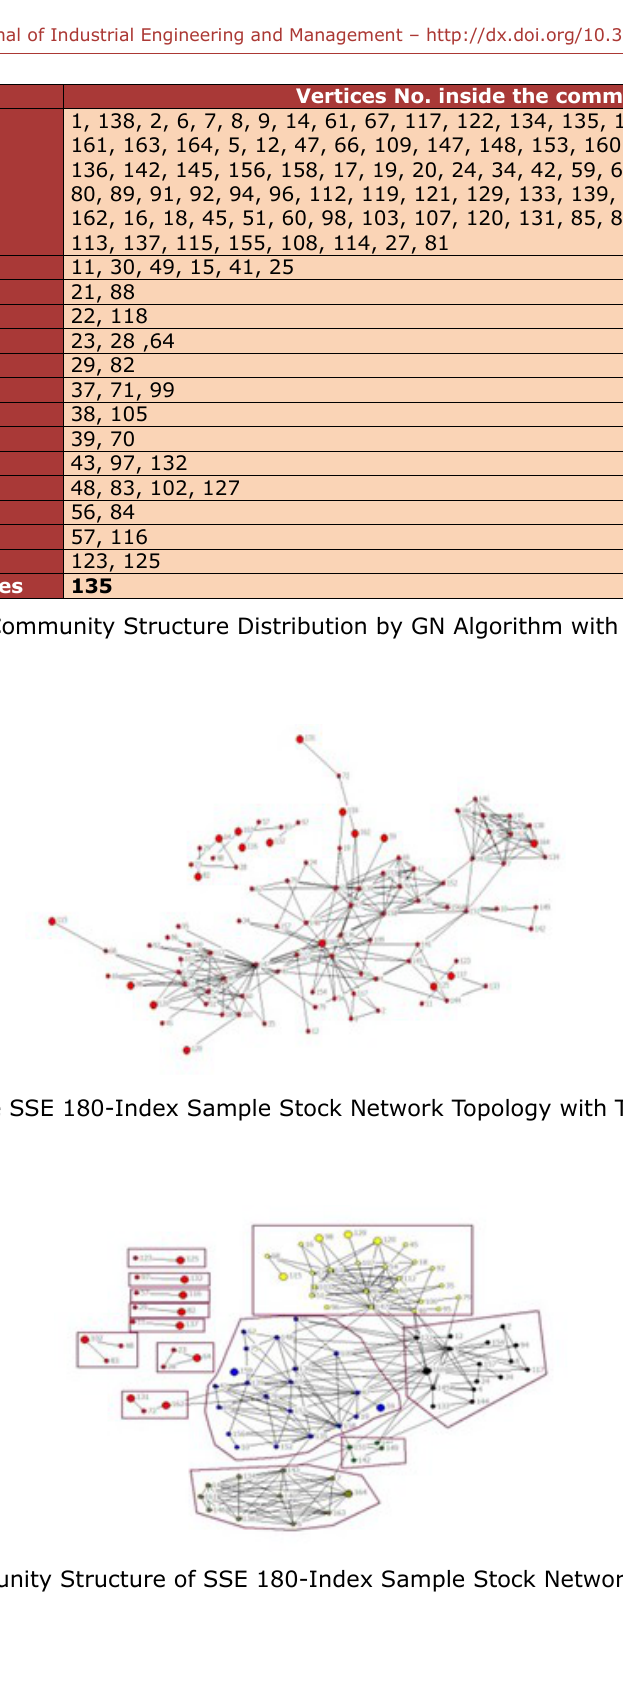
According to the result of community structure detection, there are 13 communities. Nine of them include 2 to 4 vertices, which is too few for community detection. So, we just analyze the first four communities.